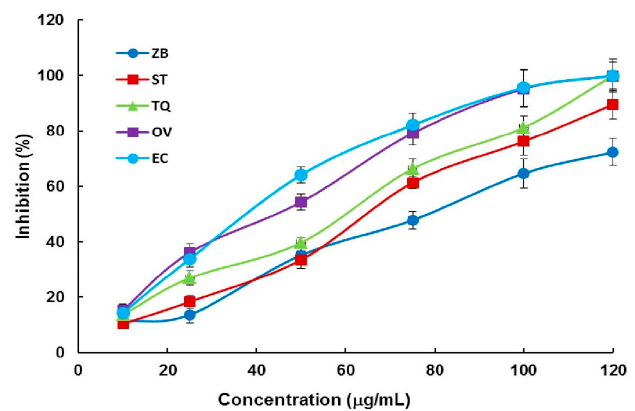
Figure3. Concentration-dependent1-deoxy- d -xylulose-5-phosphatereductoisomerase(DXR)inhibition Figure 3. Concentration-dependent 1-deoxy- D -xylulose-5-phosphate reductoisomerase (DXR) manners of the EOs of ZB, ST, TQ, OV, and inhibition manners of the EOs of ZB, ST, TQ, OV, and EC. Table 1. IC 50 values of the EOs of ZB, ST, TQ, OV, and EC against DXR. EOs